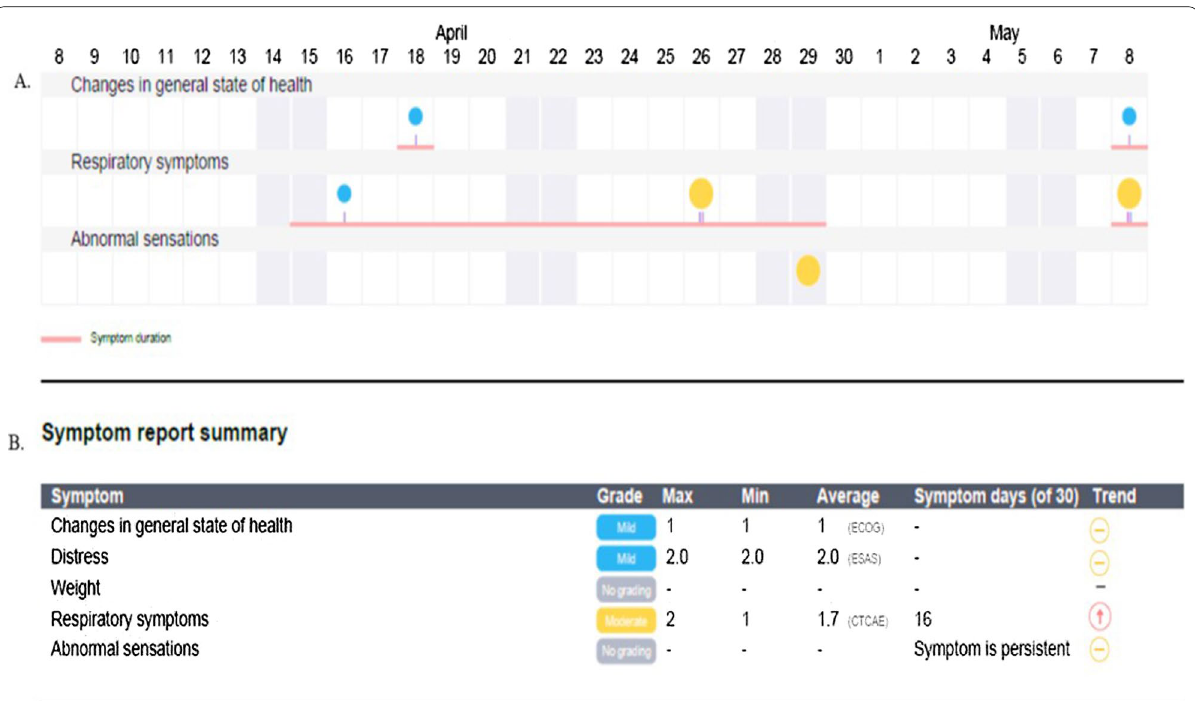
Fig. 1 Visualization of symptoms—imeline and summary reports on ePRO platform. Panel A Calendar format for symptom type, severity, and duration. Panel B Report summary listing symptoms by grade, maximum and minimum values, duration, and improved, worsening, or stable